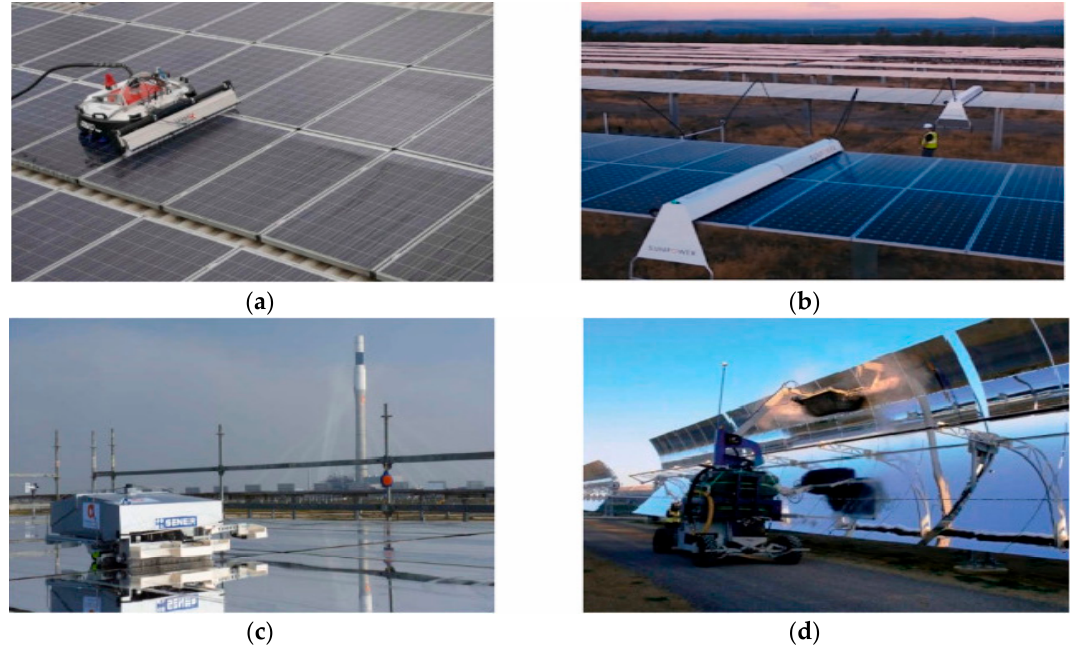
Figure 3. Robotic cleaning examples [5]: ( a ) GEKKO, from SEBROT AG; ( b ) SunPower Oasis, from SUNPOWER company; ( c ) HECTOR, from SENER company; ( d ) PARIS from SENER company.